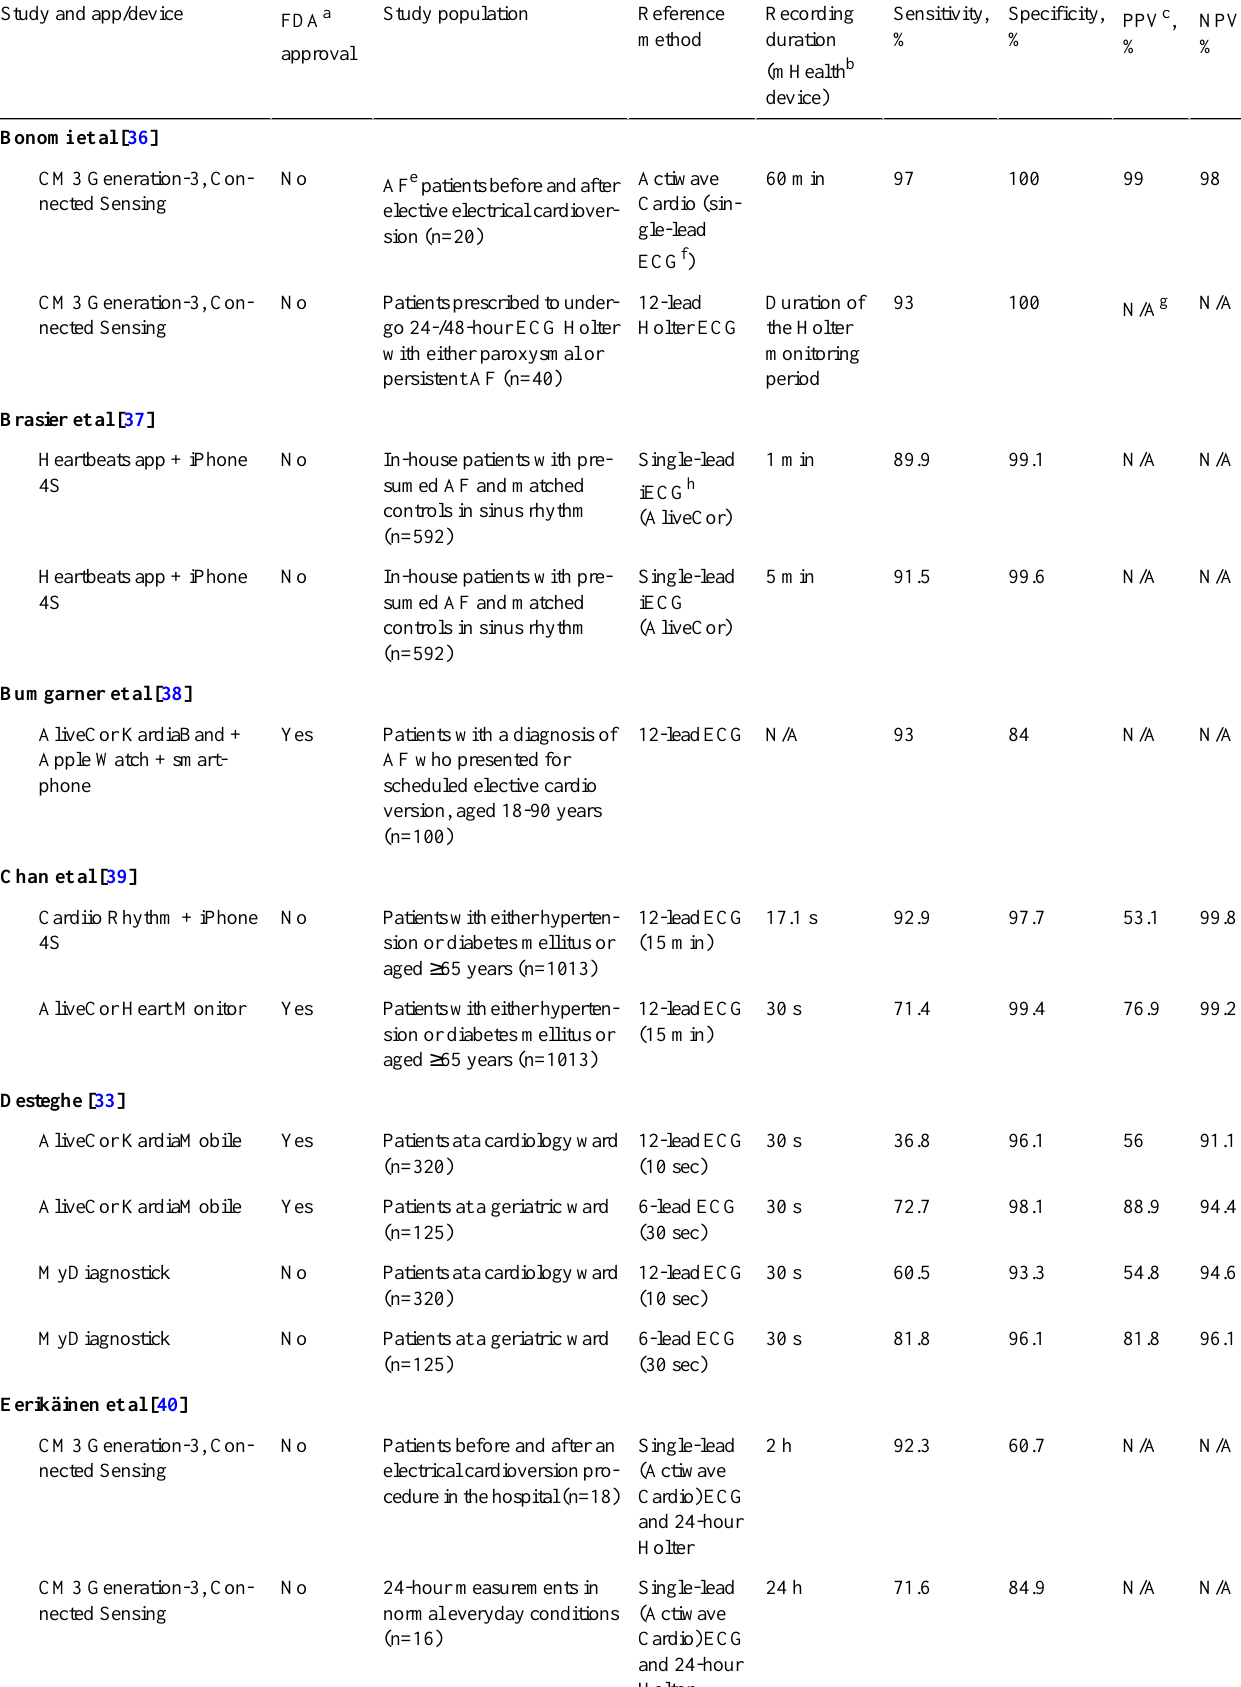
Table 1. Overview of all studies included in the